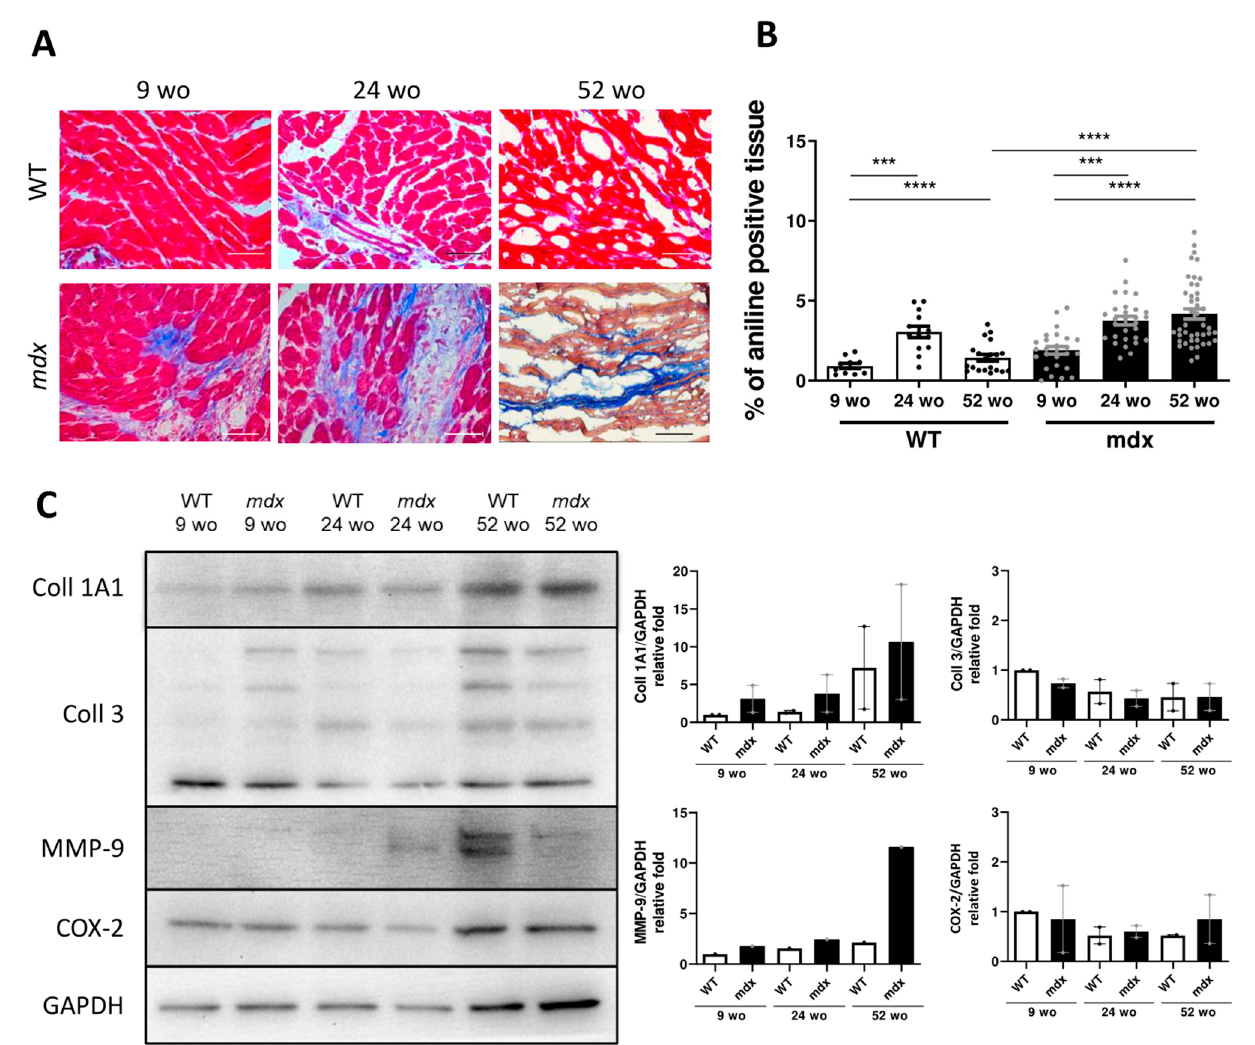
Figure 4. Fibrotic deposit and cardiac dysfunction correlate with decreasing CVPC presence in mdx heart. ( A ) Representative images of histological analysis stained using Masson trichrome technique showing myocytes (in red) and collagenous fibrotic tissue (in blue) in the left ventricle of WT and mdx hearts at 9, 24, and 52 wo. Line represents 100 μ m. ( B ) The ratio of red and blue stained tissue was evaluated in WT hearts (open bars and black dots, n = 4–11 slices/3 animals per group) and mdx hearts (black bars and grey dots, n = 3–16 slices/3 animals per group) at the age of 24 wo and further at 52 wo. Statistical significance was calculated by Kruskal–Wallis test and Dunn‘s multiple comparison post ‐ hoc test (*** p < 0.001, **** p < 0.0001). ( C ) Western blot analysis of collagen proteins and inflammatory proteins in the cardiac tissues. Left panel shows representative images of collagen 1A1 (Coll 1A1), collagen 3 (Coll 3), cyclooxygenase 2 (COX ‐ 2), and matrix metalloproteinase 9 (MMP ‐ 9) compared to the GAPDH control. The right panels show the normalized densitometry of each protein normalized by GAPDH content of WT (open bars, n = 2 animals) and mdx (black bars, n = 2 animals).